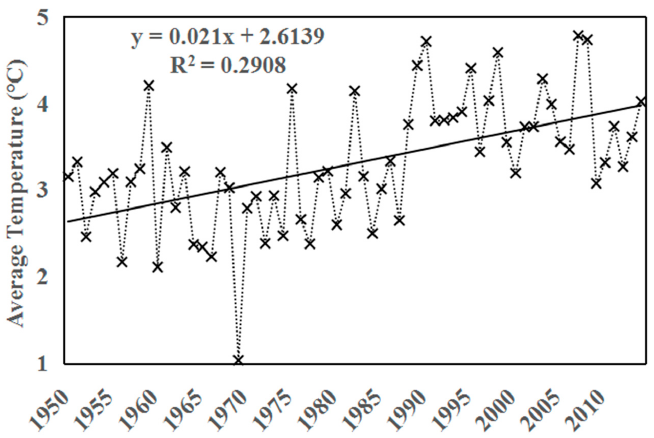
Figure 10. Average yearly temperature changes from 1954 to 2015.